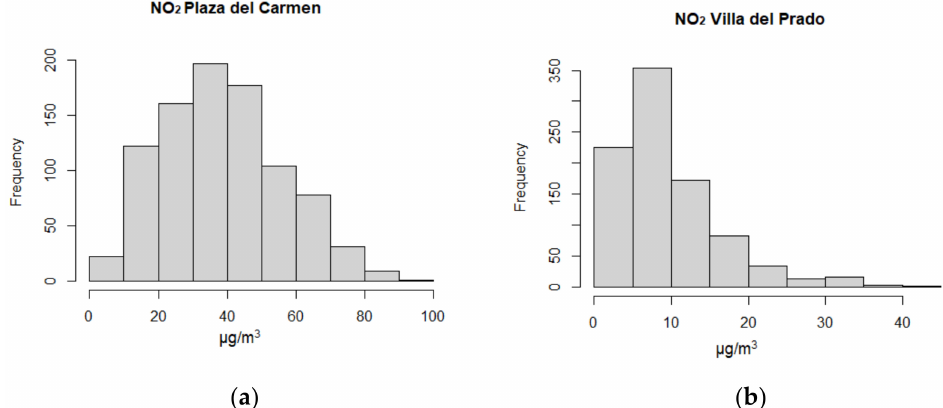
Figure 4. Histogram of average daily levels of NO 2 between January 2018 and June 2020. ( a ) Plaza del Carmen air monitoring station, ( b ) Villa del Prado air monitoring